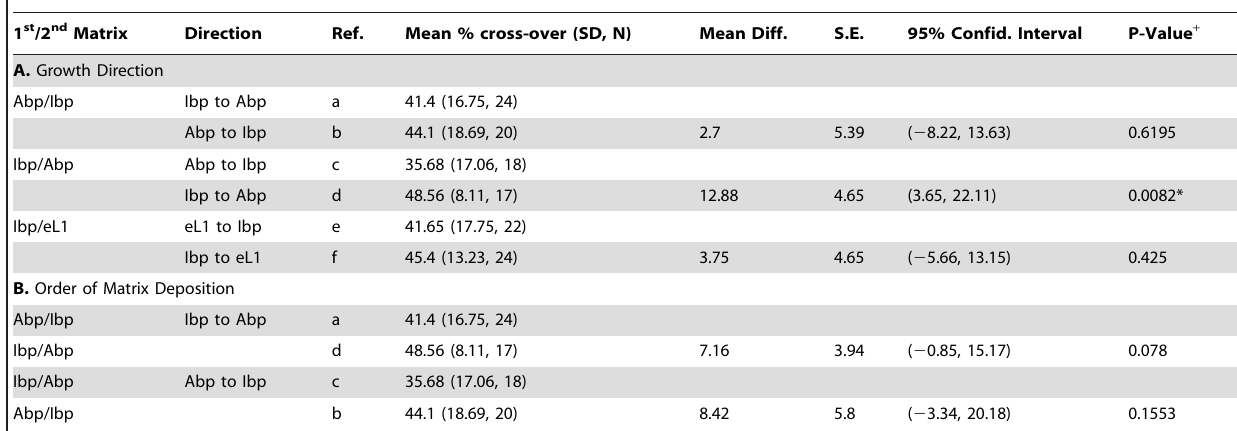
Table 7. Haptotactic Assay Controls, wt Neurons.